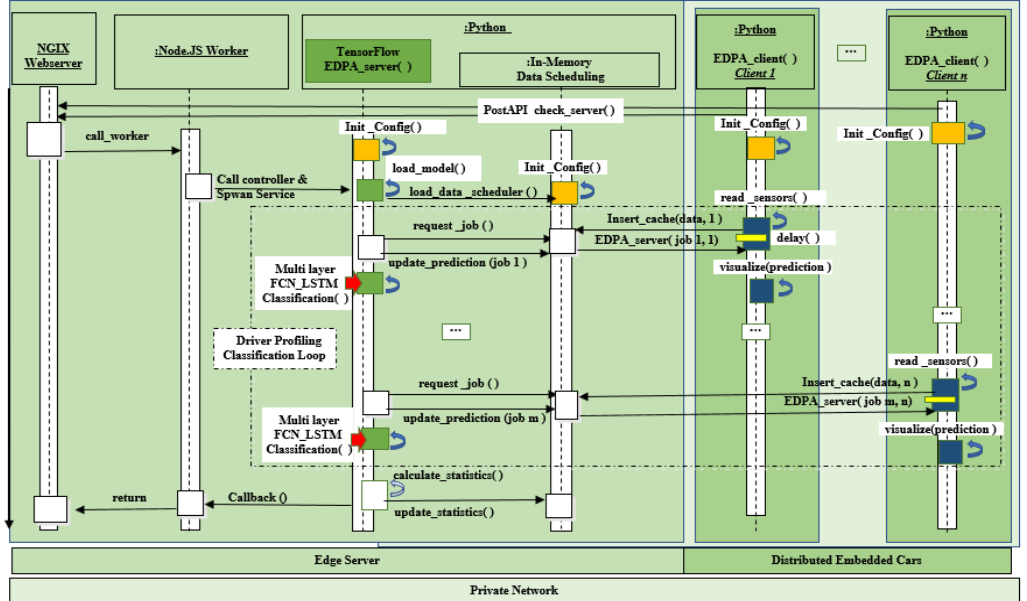
Figure 2. The proposed edge-based data scheduling